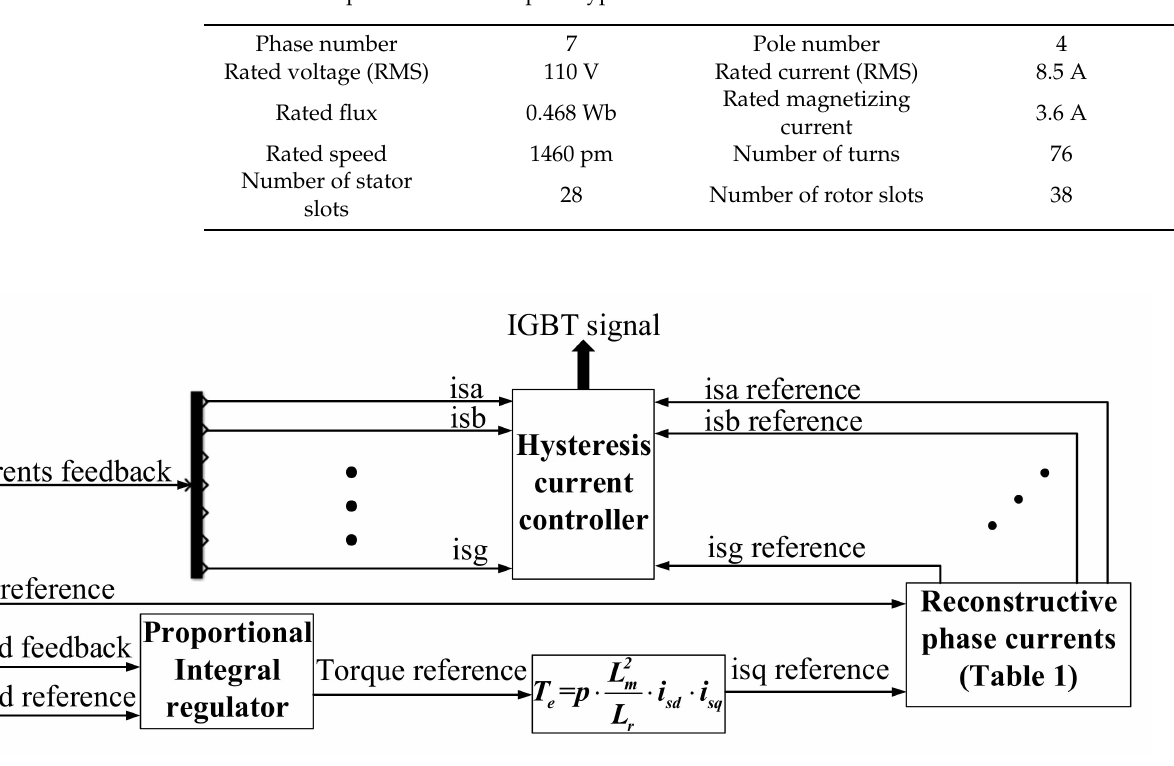
Figure 3. Block diagram of the C program